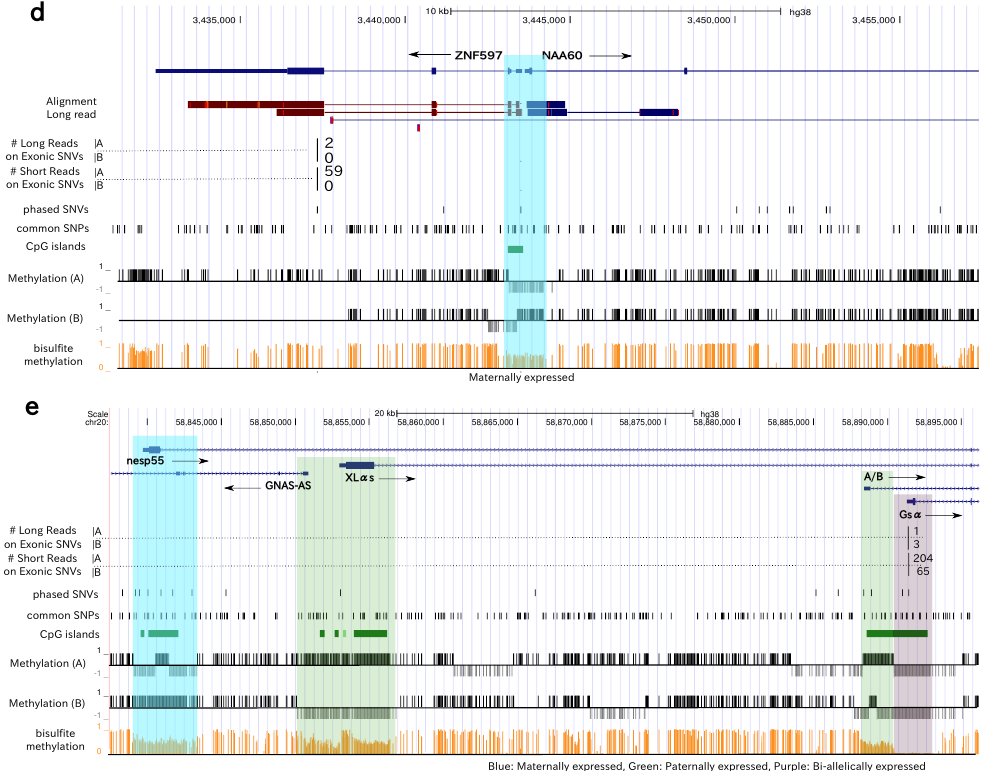
Blue: Maternally expressed, Green: Paternally expressed, Purple: Bi-allelically expressed